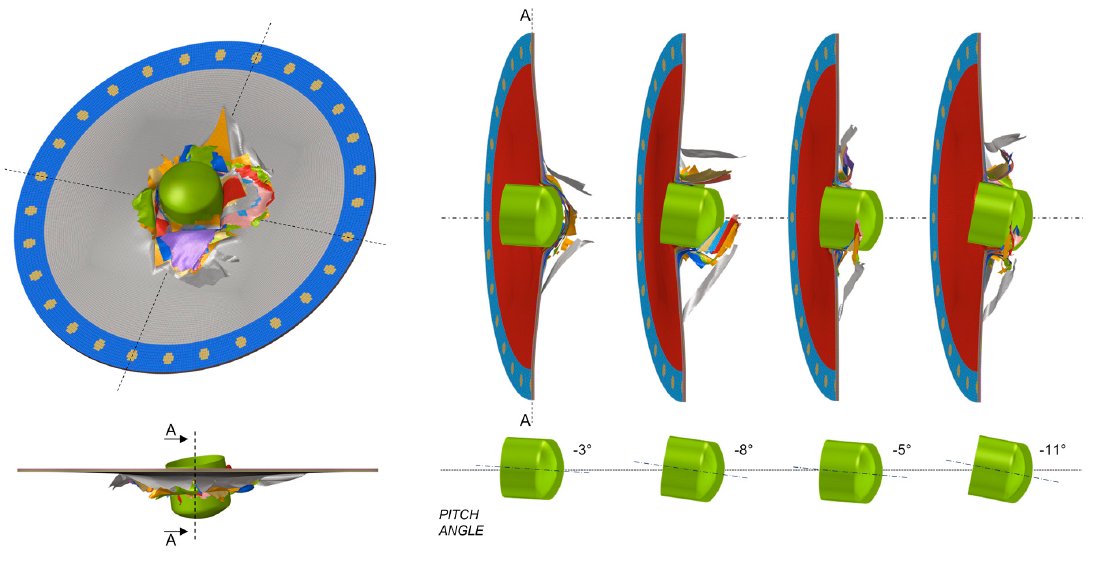
Figure 8. Projectile at 127 m/s induced damage: progressive time evolution of the composite fracture and variation of the pitch angle of the ASTM projectile.